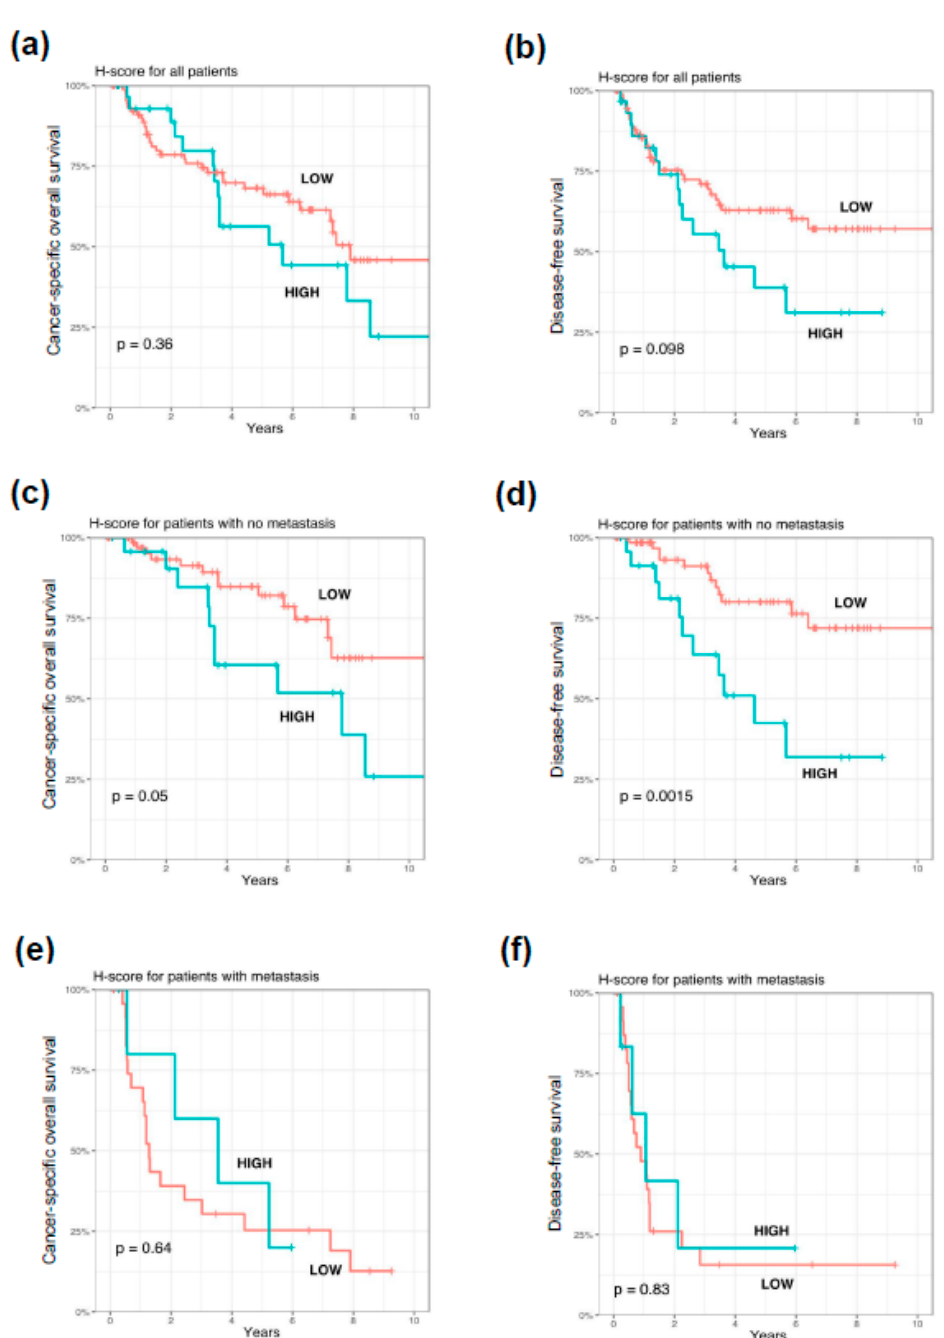
Figure 4. Kaplan–Meier analysis of the prognostic significance of PARP1 expression in cutaneous melanoma patients. PARP1 overexpression had no prognostic significance in the entire study group of cutaneous melanoma patients ( a , b ). In the lymph node-negative subgroup of cutaneous melanoma patients, increased PARP1 immunoreactivity corresponded with shorter cancer-specific overall survival ( c ) and significantly correlated with reduced disease-free survival ( d ). Prognostic significance of PARP1 immunoreactivity in lymph node-positive melanoma patients was not observed ( e , f ). p levels of the log-rank test.